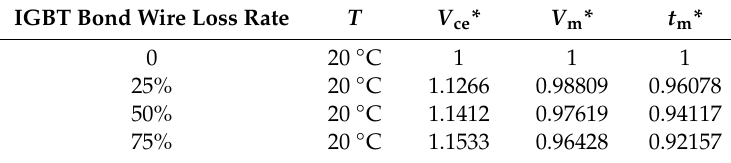
Table 7. Data after